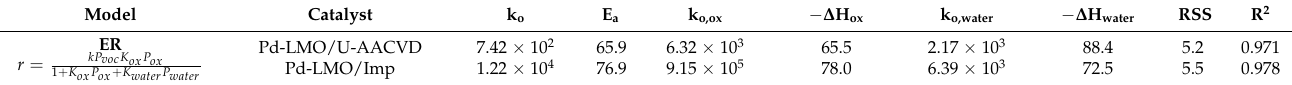
Table 6. Reaction rate expressions and kinetics parameters for applied Eley—Rideal